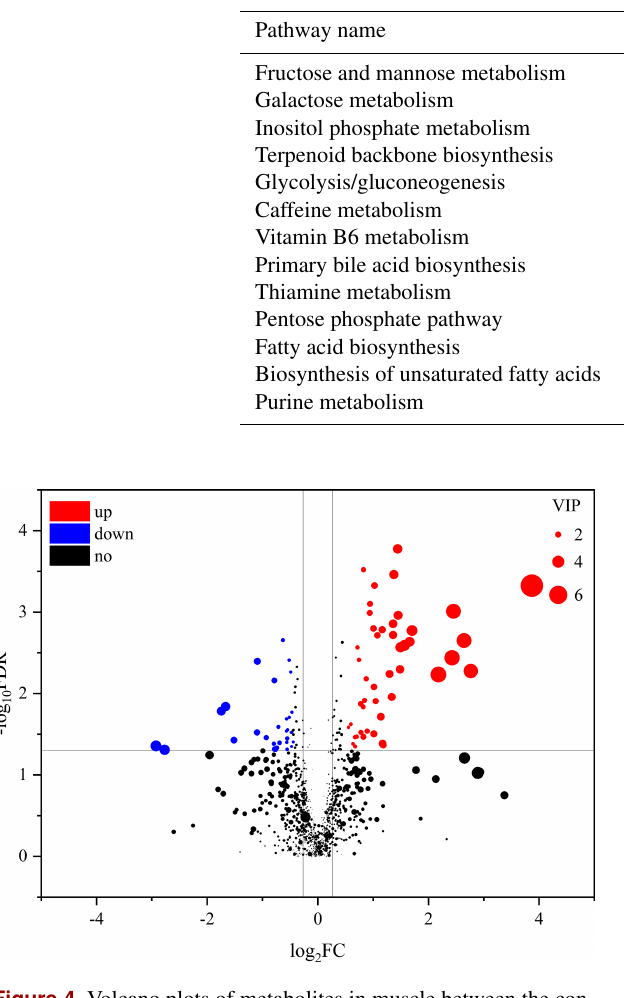
Figure 4. Volcano plots of metabolites in muscle between the con- trol group and treatment group. Each dot represents a metabolite. The larger dots indicate higher variable importance in the projection (VIP) values. The abscissa and ordinate represent the fold change and P value of metabolites, respectively. The increased and de- creased ( P< 0 . 05) metabolites in the treatment group (TG) are rep- resented by the red and blue dots, respectively, and the black dots represent the unchanged metabolites ( P> 0 . 05) between the two